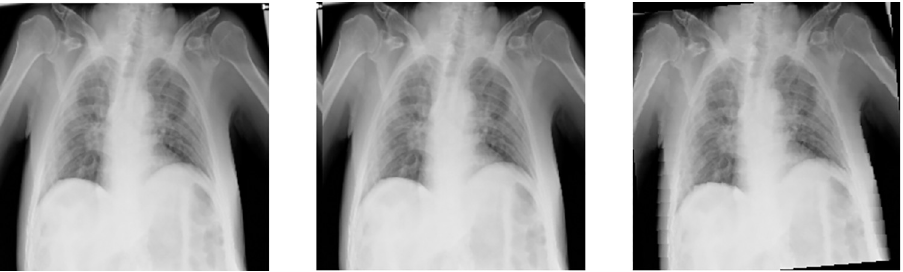
Fig 2. Translation and rotation of the chest X-ray image. (a) original image, (b) translated image, (c) Rotated image.